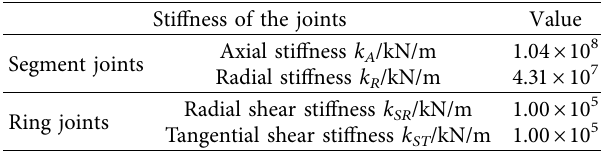
Table 3: Parameters of the joints in the beam-spring